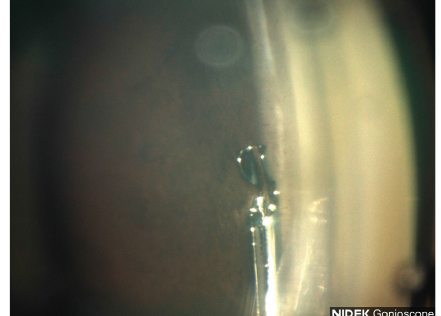
Figure 5: Hydrus stent not fully positioned and adjacent goniotomy seen performed by Sinskey hook.